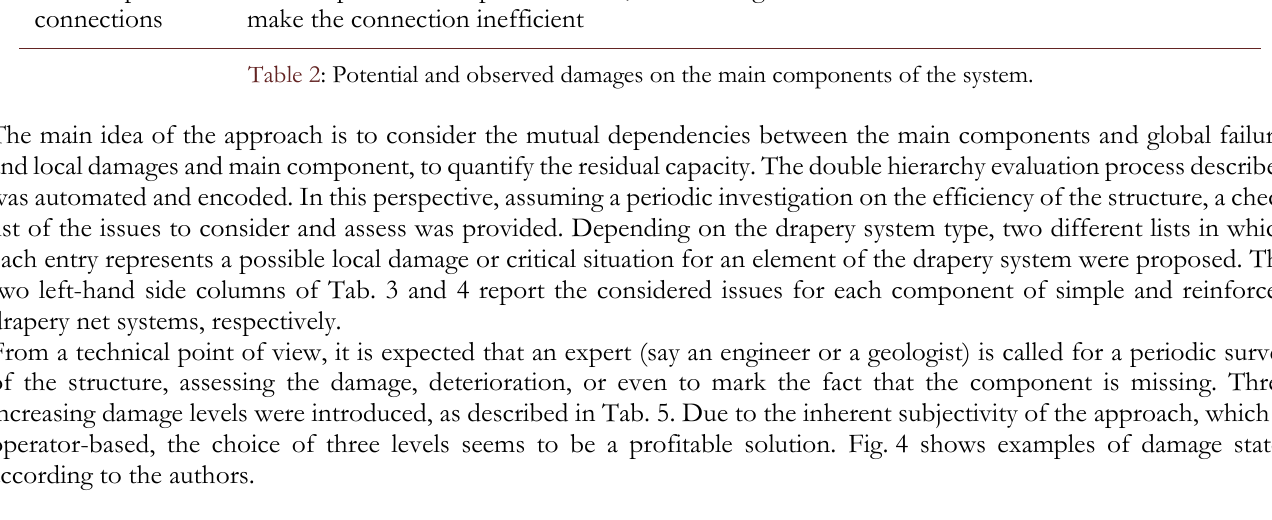
Table 2: Potential and observed damages on the main components of the